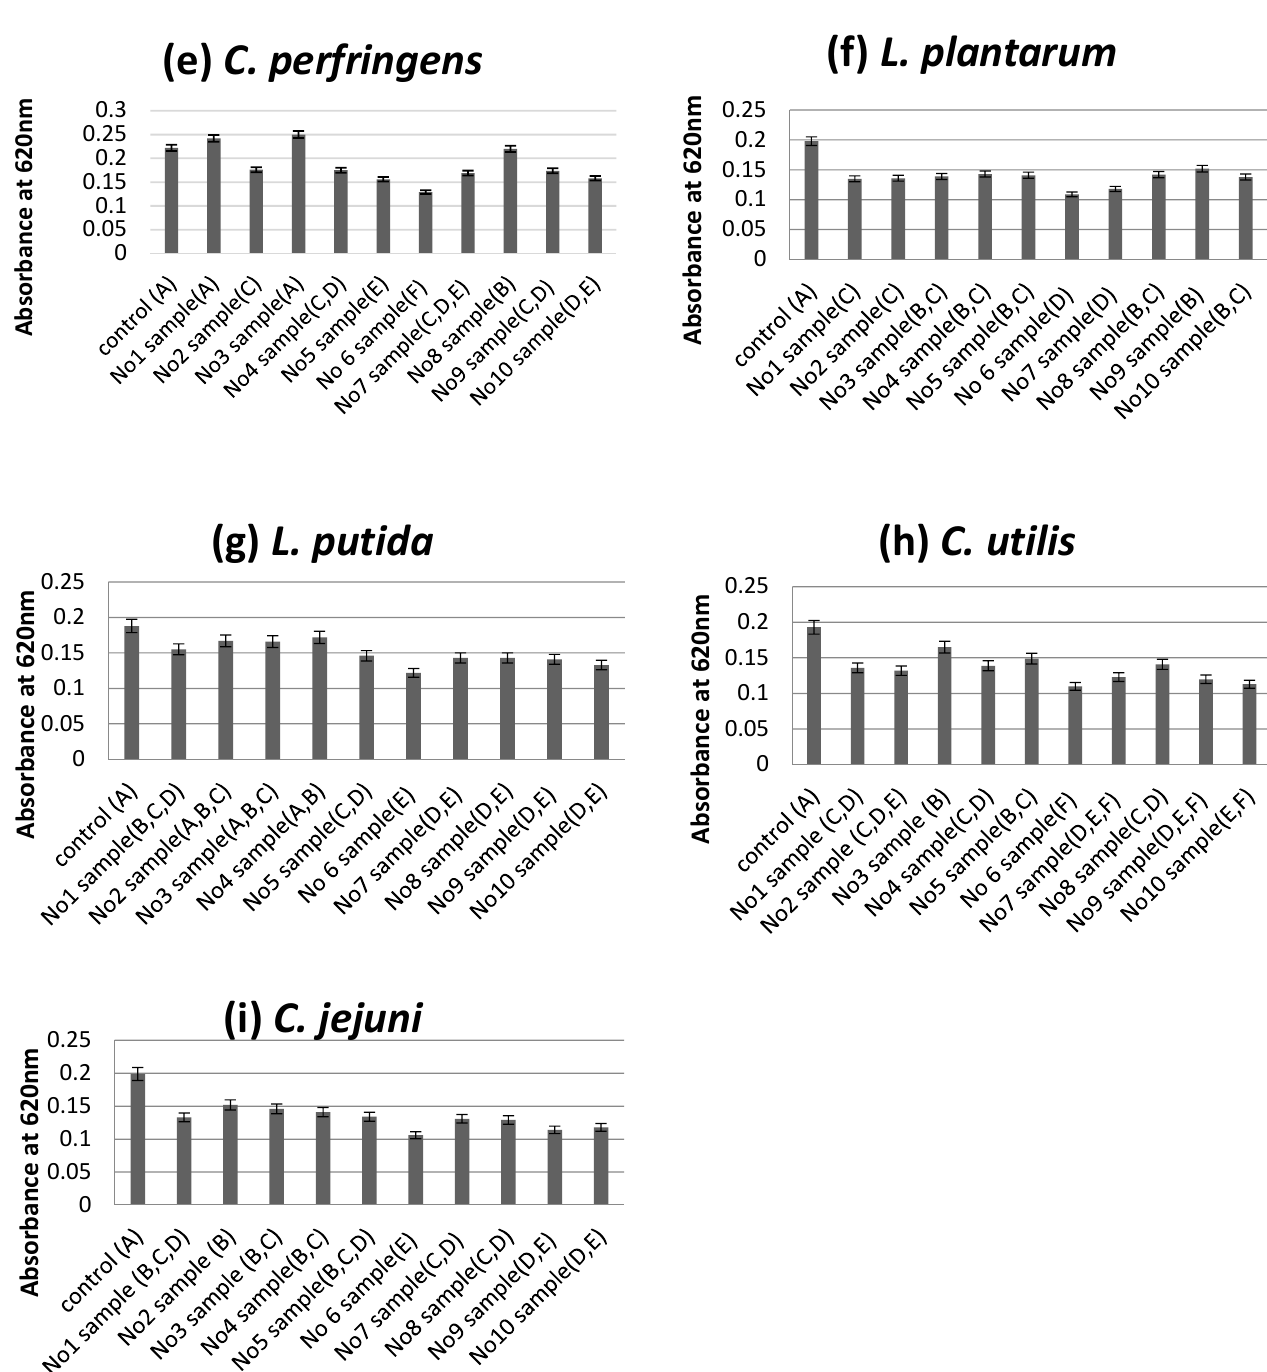
Figure 2. Optical density of the growth medium of S. typhimurium ( a ), L. monocytogenes ( b ), S. aureus ( c ), E. coli ( d ), C. perfringens ( e ), L. plantarum ( f ), L. putida ( g ), C. utilis ( h ) and C. jejuni ( i ), measured the reduction of the absorbance at 620 nm as an effect of the addition of each sample at concentrations of 10 mg/mL, compared to a control (0 mg/mL) without antimicrobial extracts. The mixtures of extracts in each sample number described in Table 6; Sample means that do not share a letter are significantly different at p ≤ 0.05 estimated by Tukey Pairwise Comparison.